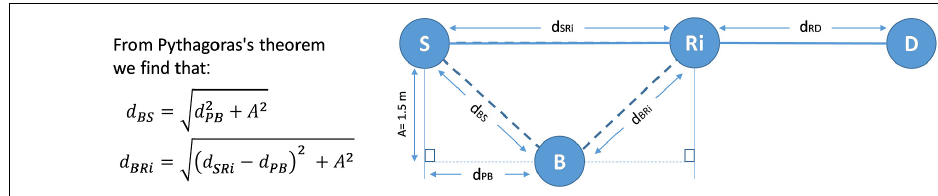
Figure 10. Localization of the PB between S and R i .